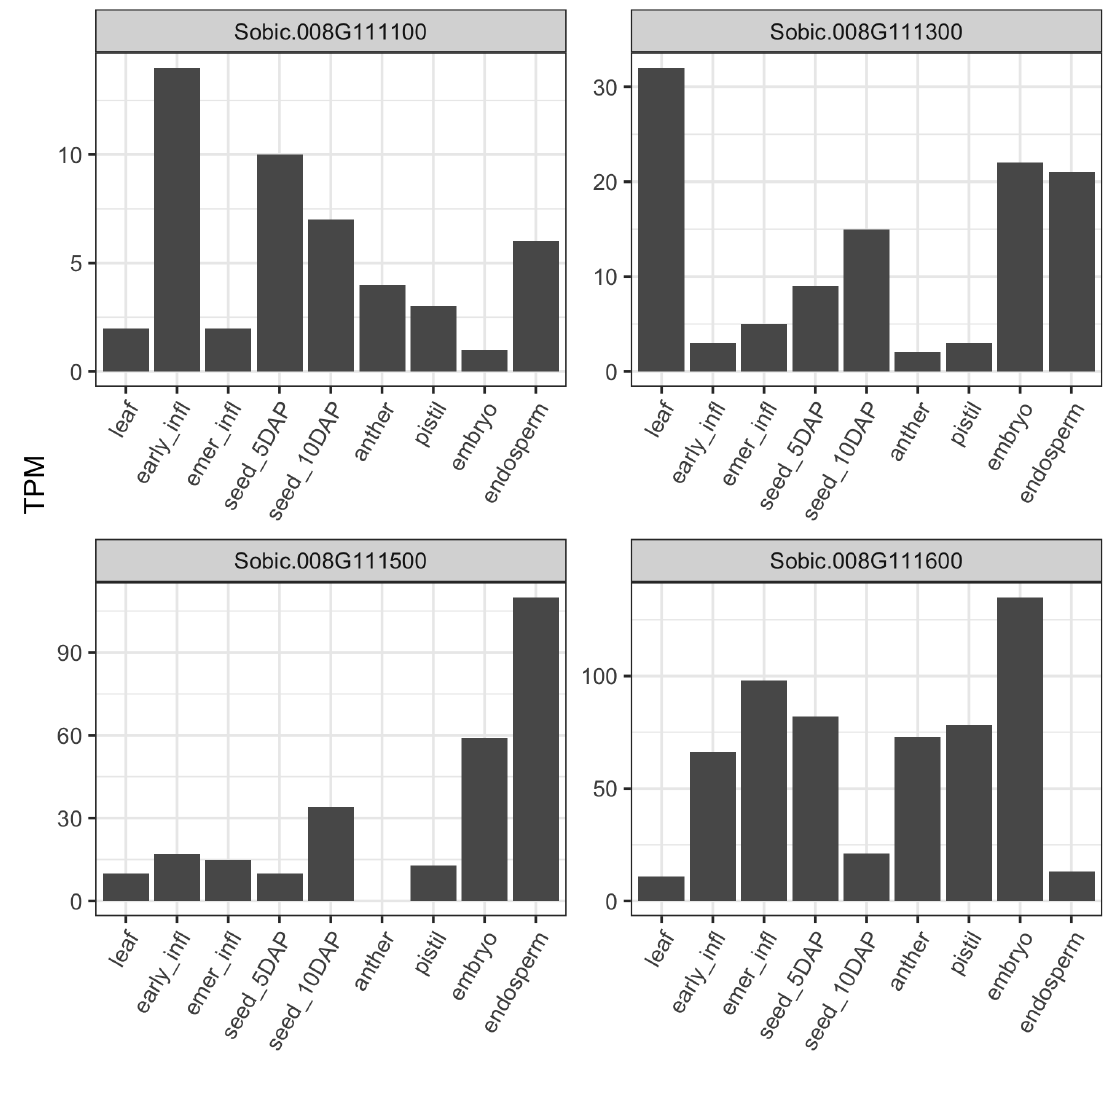
Figure 3. Gene expression profile of genes near 52 Mb associated regions: the Y-axes represent transcript abundance in transcript per million (TPM), and x-axes correspond to tissue type. infl: infloresence, emer: post-emergence, DAP: days after